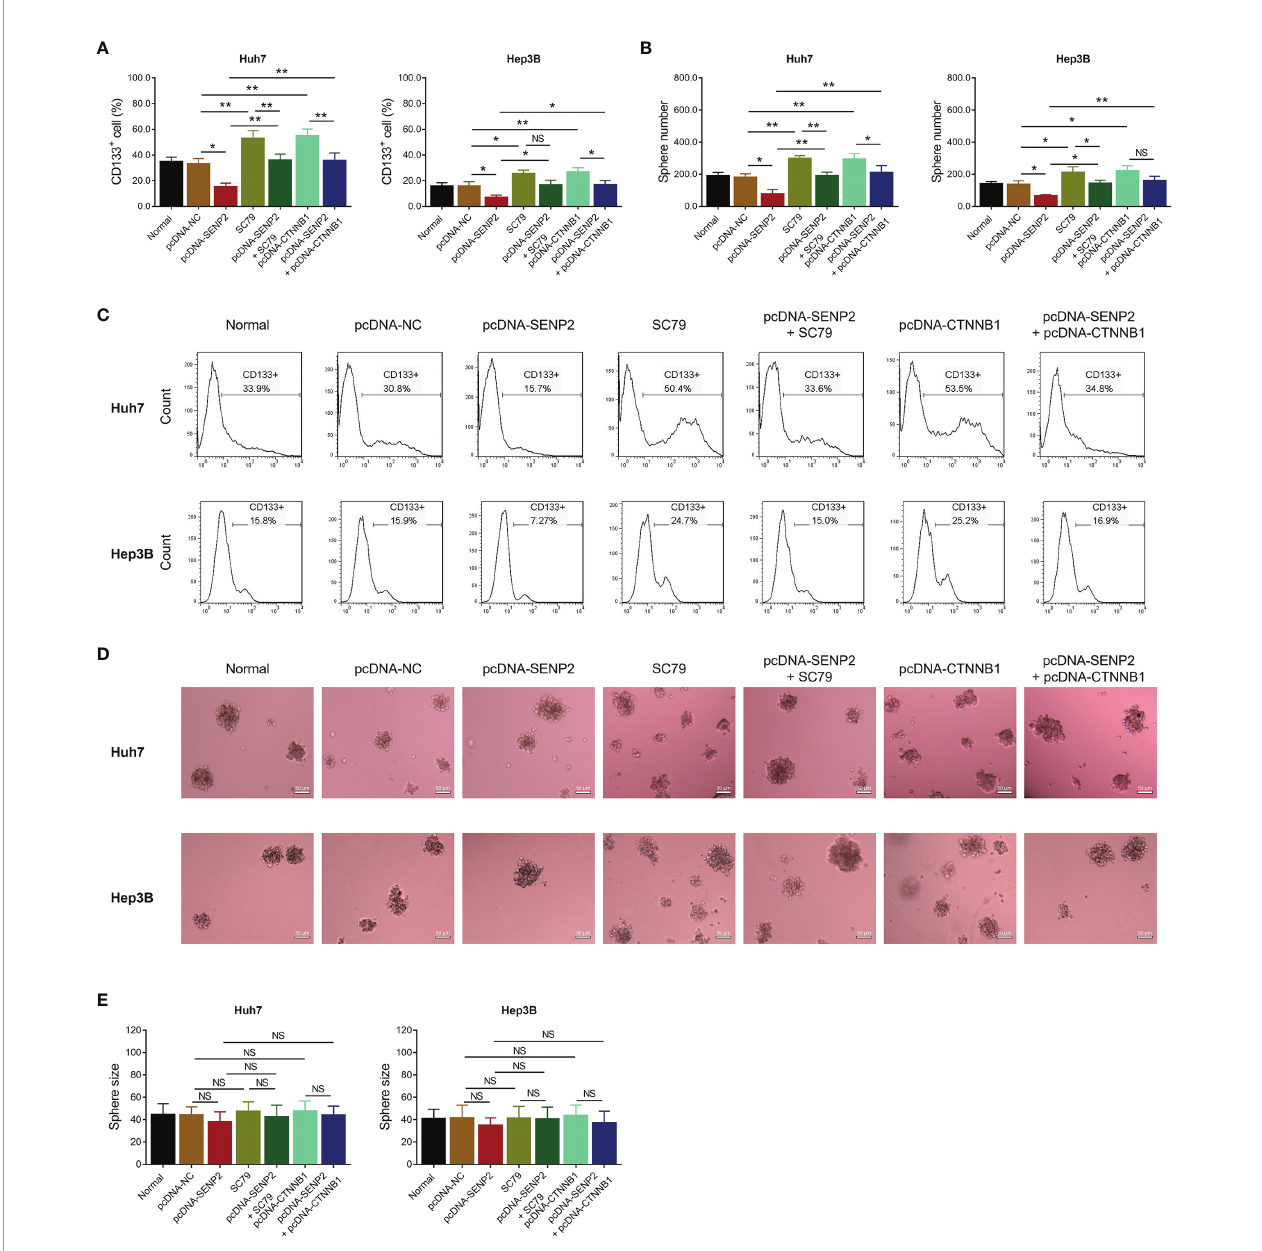
FIGURE 6 | Stemness in the compensation experiment. Comparison of CD133 + cell proportion (A) and sphere number (B) among groups in Huh7 and Hep3B cells in the compensation experiment. Representative images of CD133 + cell proportion detection by fl ow cytometry assay (C) and sphere formation assay (D) . Comparison of sphere size among groups in Huh7 and Hep3B cells in the compensation experiment (E) . SENP2, Small ubiquitin-like modi fi er speci fi c peptidase 2; NC, negative control; CTNNB1, b -catenin; CD133 + , cluster of differentiation 133 positive; * p < 0.05; ** p < 0.01; NS, not signi fi